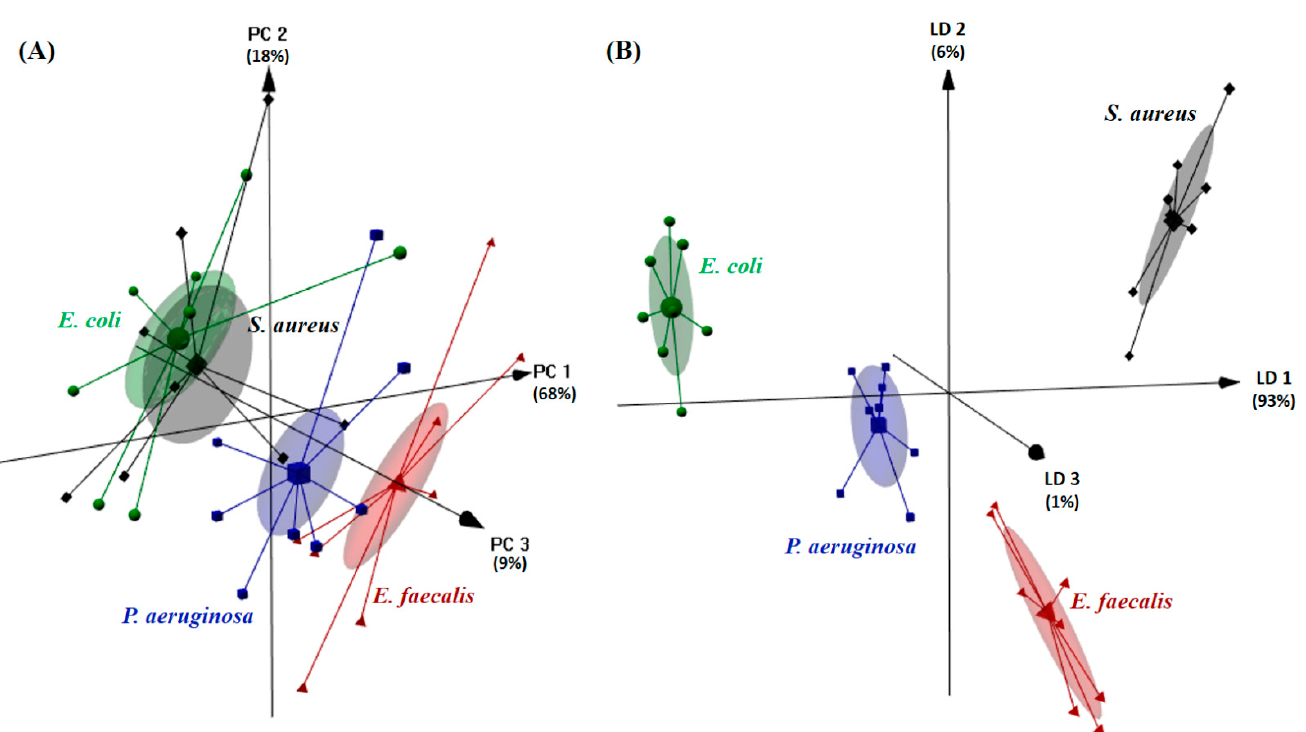
Figure 3. Differentiation (3D plots) of four common water-food contamination microorganisms based on the E-tongue signal profiles acquired during the analysis of aqueous solutions of E. coli (0.309 to 0.666 mg/mL, symbol ● ), E. faecalis (0.279 to 0.538 mg/mL, symbol ▲ ), S. aureus (0.511 to 0.702 mg/mL, symbol ♦ ) and P. aeruginosa (0.324 to 0.435 mg/mL, symbol ■ ). ( A ) Unsupervised PCA recognition based on the potentiometric signals of 40 E-tongue sensors; and ( B ) supervised LDA classification based on the potentiometric signals of a set of 12 non-redundant E-tongue sensors, selected by the SA algorithm.